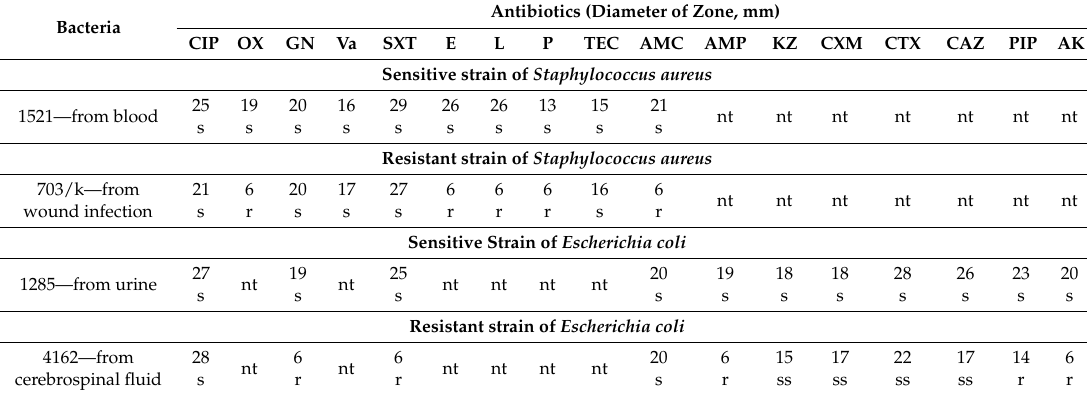
Table 1. Antibiogram pattern of Staphylococcus aureus and Escherichia coli strains used in the study, isolated from